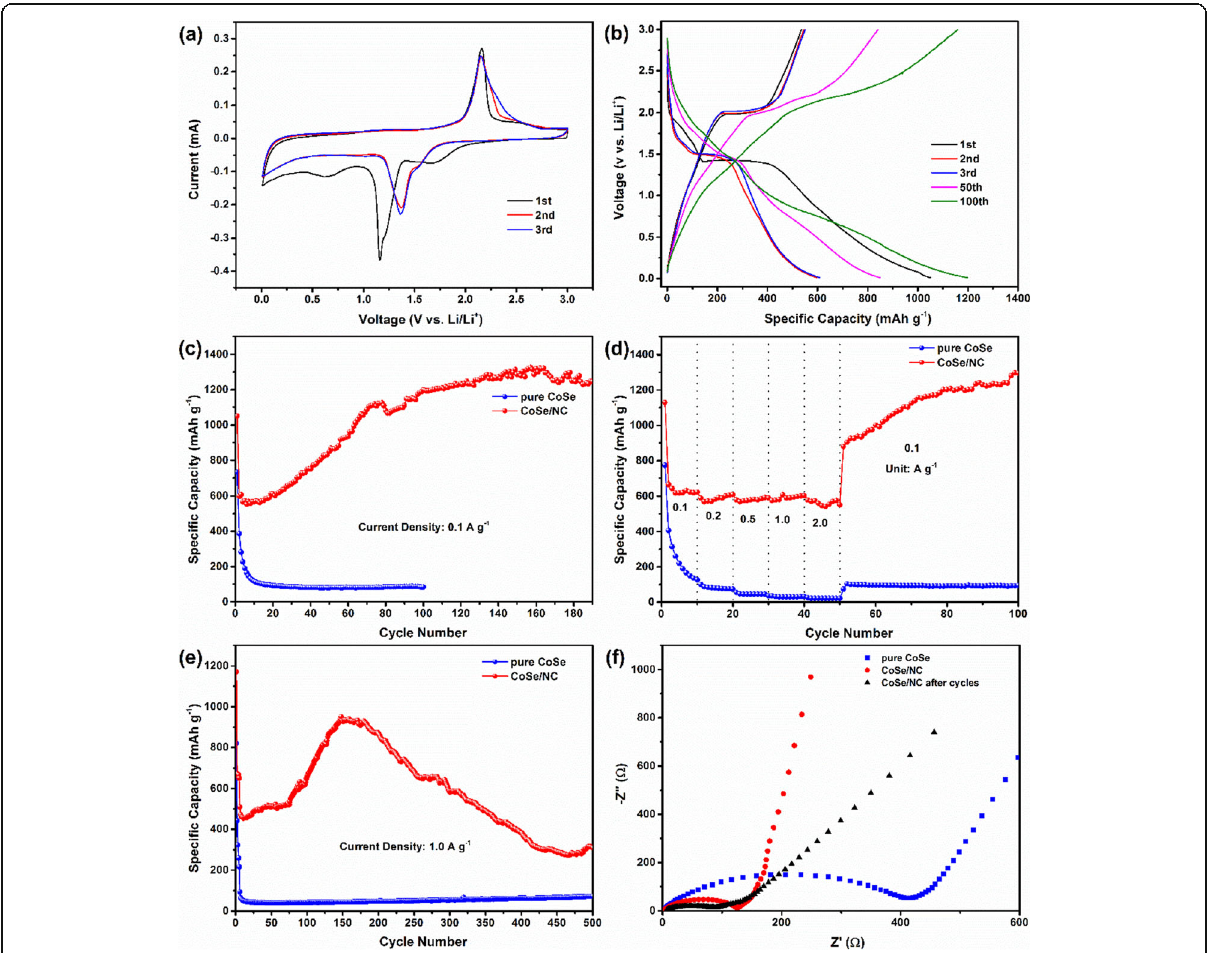
Fig. 6 a The CV curves of CoSe/NC at 0.2mVs − 1 . b Galvanostatic discharge/charge voltage profiles of CoSe/NC at 0.1 A g − 1 . c Cycling performance of CoSe/NC and pure CoSe at 0.1 A g − 1 . d Rate performance of CoSe/NC and pure CoSe at 0.1 to 1.0 A g − 1 . e Long-current cyclic performances of CoSe/ NC and pure CoSe at 1.0 A g − 1 . f EIS spectras of pure CoSe, and CoSe/NC before and after